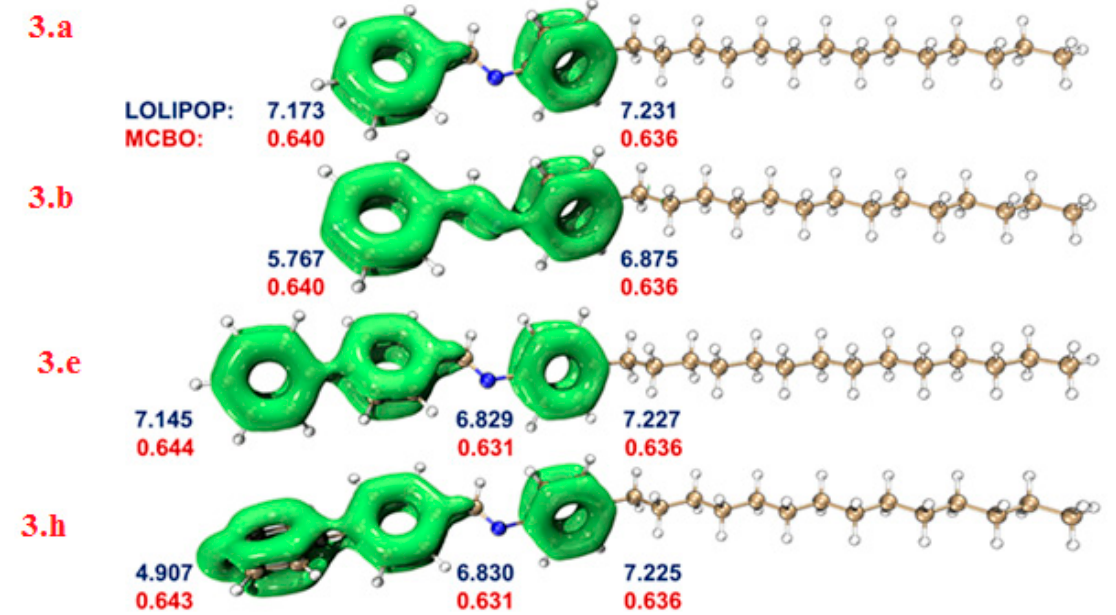
Figure 7. Isosurface maps of LOL- π (Isovalue = 0.3) with labeling for the LOLIPOP index and normalized MCBO aromaticity index.